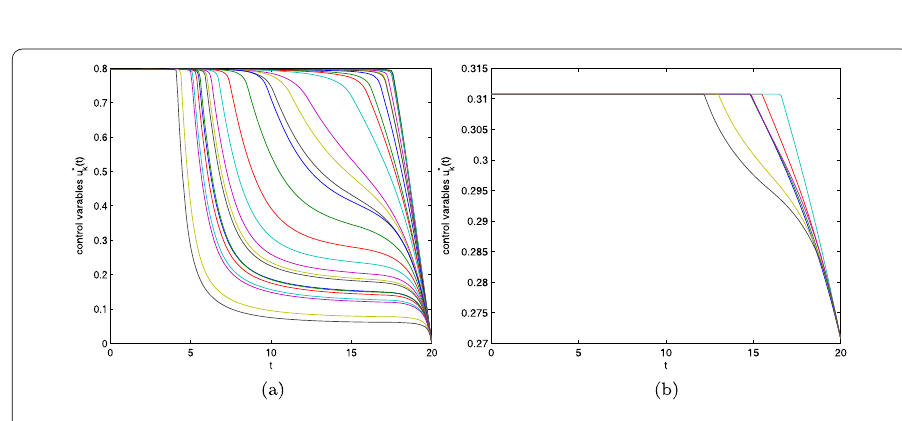
Figure 4 The dynamical process of the optimal control variables u ∗